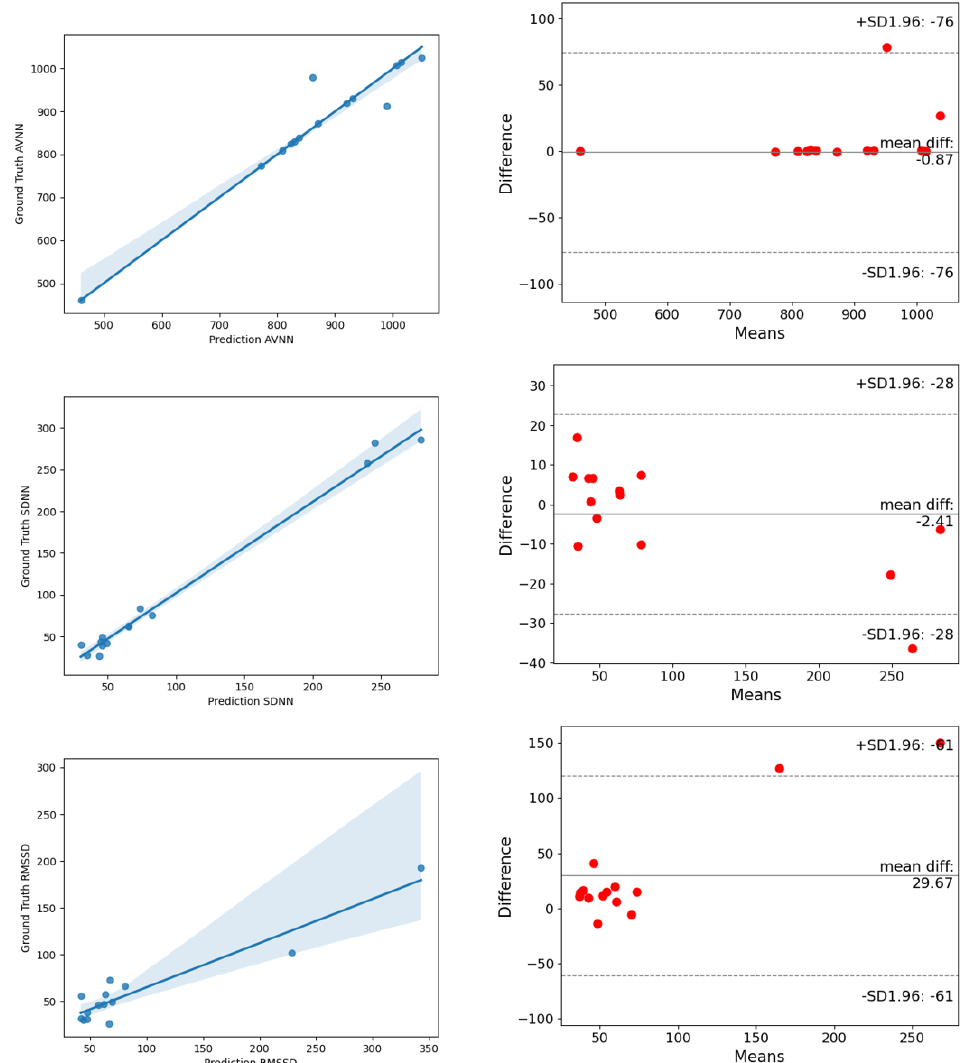
Figure 16. The analysis of the correlation plot ( left ) and the Bland–Altman plot ( right ) of time-domain metrics of HRV on the PURE dataset. ( top ) is AVNN, ( middle ) is SDNN, ( bottom ) is